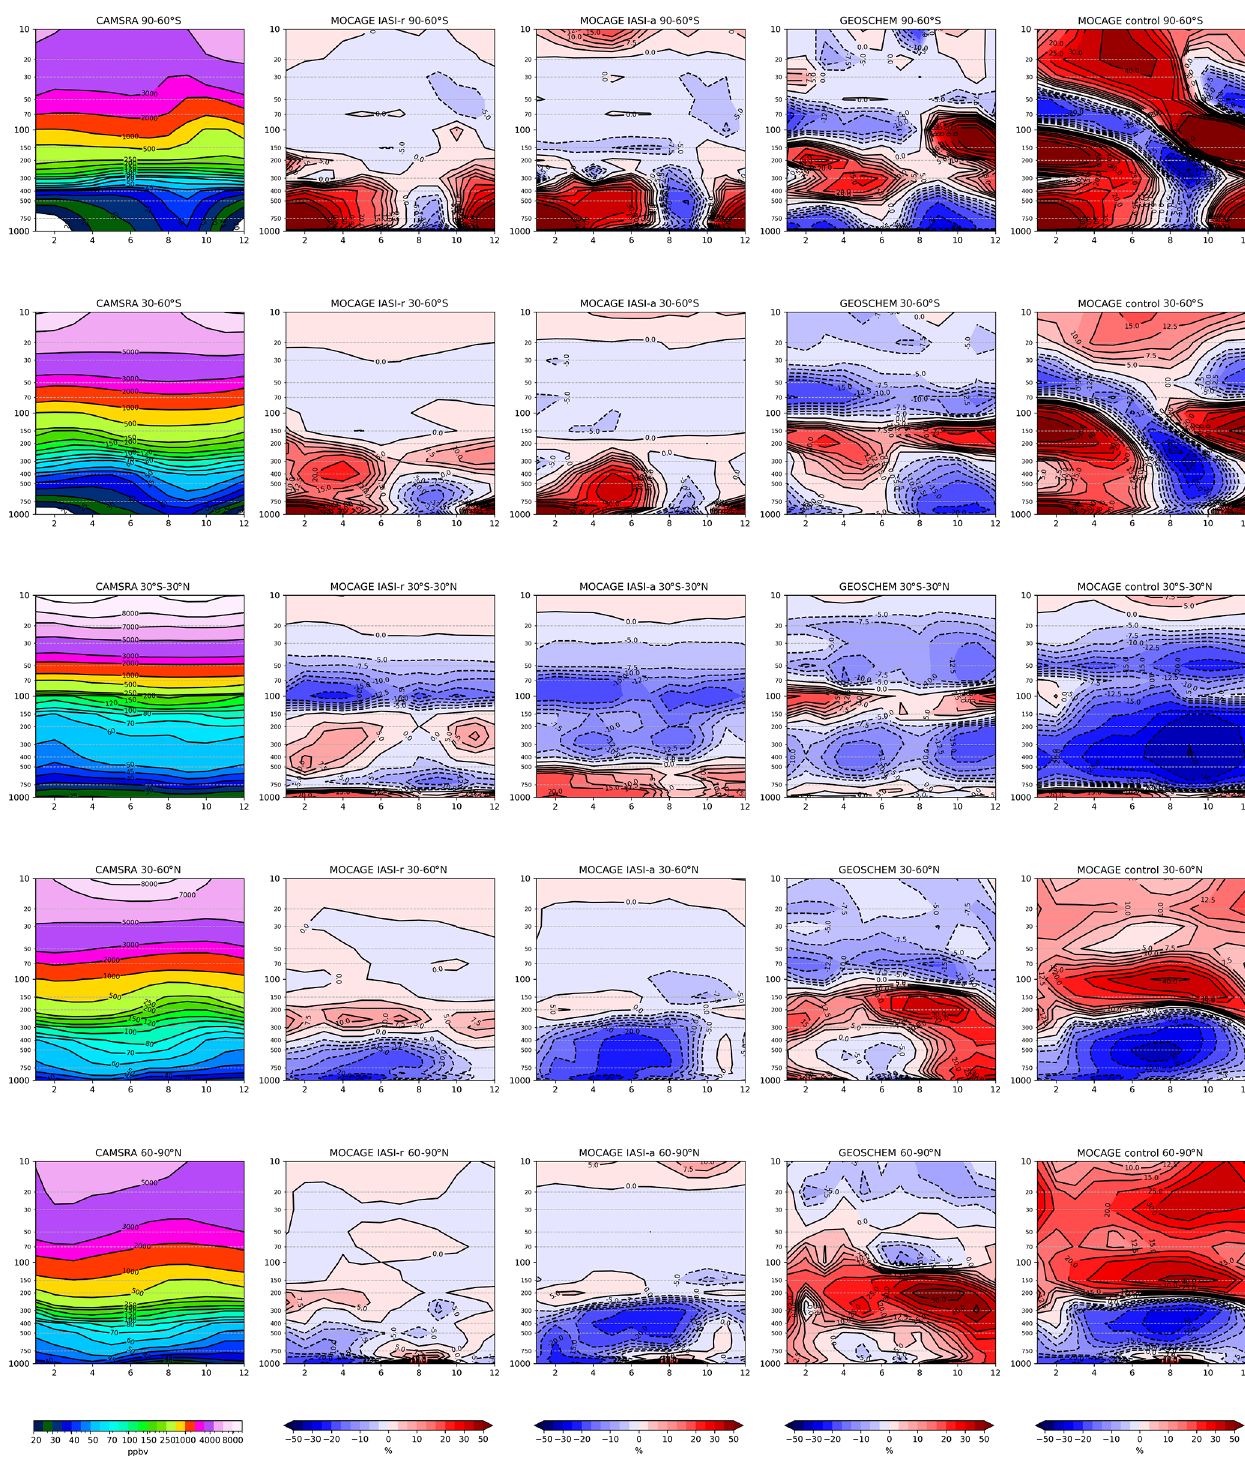
Figure 9. Ozone zonal averages as a function of month ( x axis) and altitude ( y axis, in hPa) for five respective latitude bands: 90–60 ◦ S, differences between IASI-r (second column), IASI-a (third column), GEOS-CCM (fourth column), the MOCAGE control simulation (fifth column) and CAMSRA O 3 are given as a percentage of the CAMSRA O 3